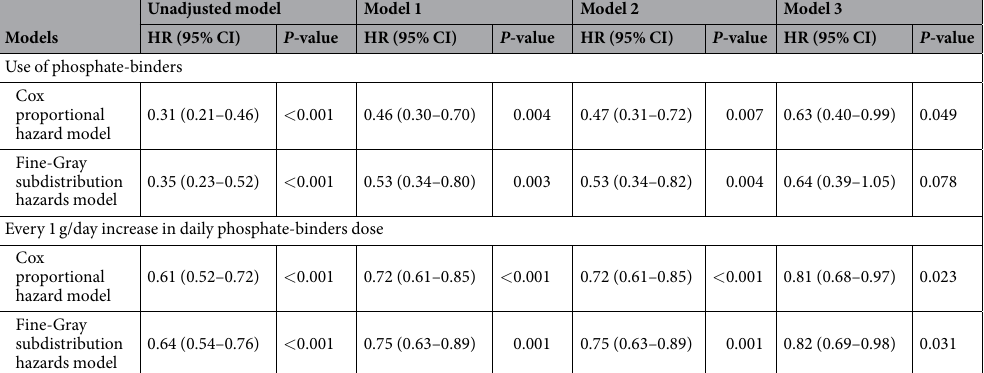
Table 2. Association between treatment with phosphate-binders and infection-related mortality (n = 2926). The risk estimates are expressed as HR (95%CI). The HR was estimated using Cox proportional hazard model for conventional approach and Fine-Gray subdistribution hazards model for dealing with competing risk. The following covariates were included in each model: Model 1, age, sex, presence of diabetes mellitus and comorbidity, dialysis vintage, dialysis time per session, Kt/V for urea; Model 2, covariates in Model 1, cardiothoracic ratio, systolic blood pressure, blood hemoglobin level, serum levels of corrected calcium, phosphate, alkaline phosphatase, parathyroid hormone, use of erythropoiesis stimulating agents, anti- hypertensives, and vitamin D receptor activators; Model 3, covariates in Model 2, normalized protein catabolic rate, body mass index, serum levels of urea nitrogen, creatinine, albumin, total cholesterol, and C-reactive protein. Total daily dose of phosphate-binders was expressed as that of calcium carbonate. In this study, Phosphate binding capacity of 750 mg of sevelamer dose was regarded equivalent to that of 500 mg of calcium carbonate. A two-tailed P -value less than 0.05 was considered statistically significant. Abbreviations: CI, confidence interval; HR, hazard